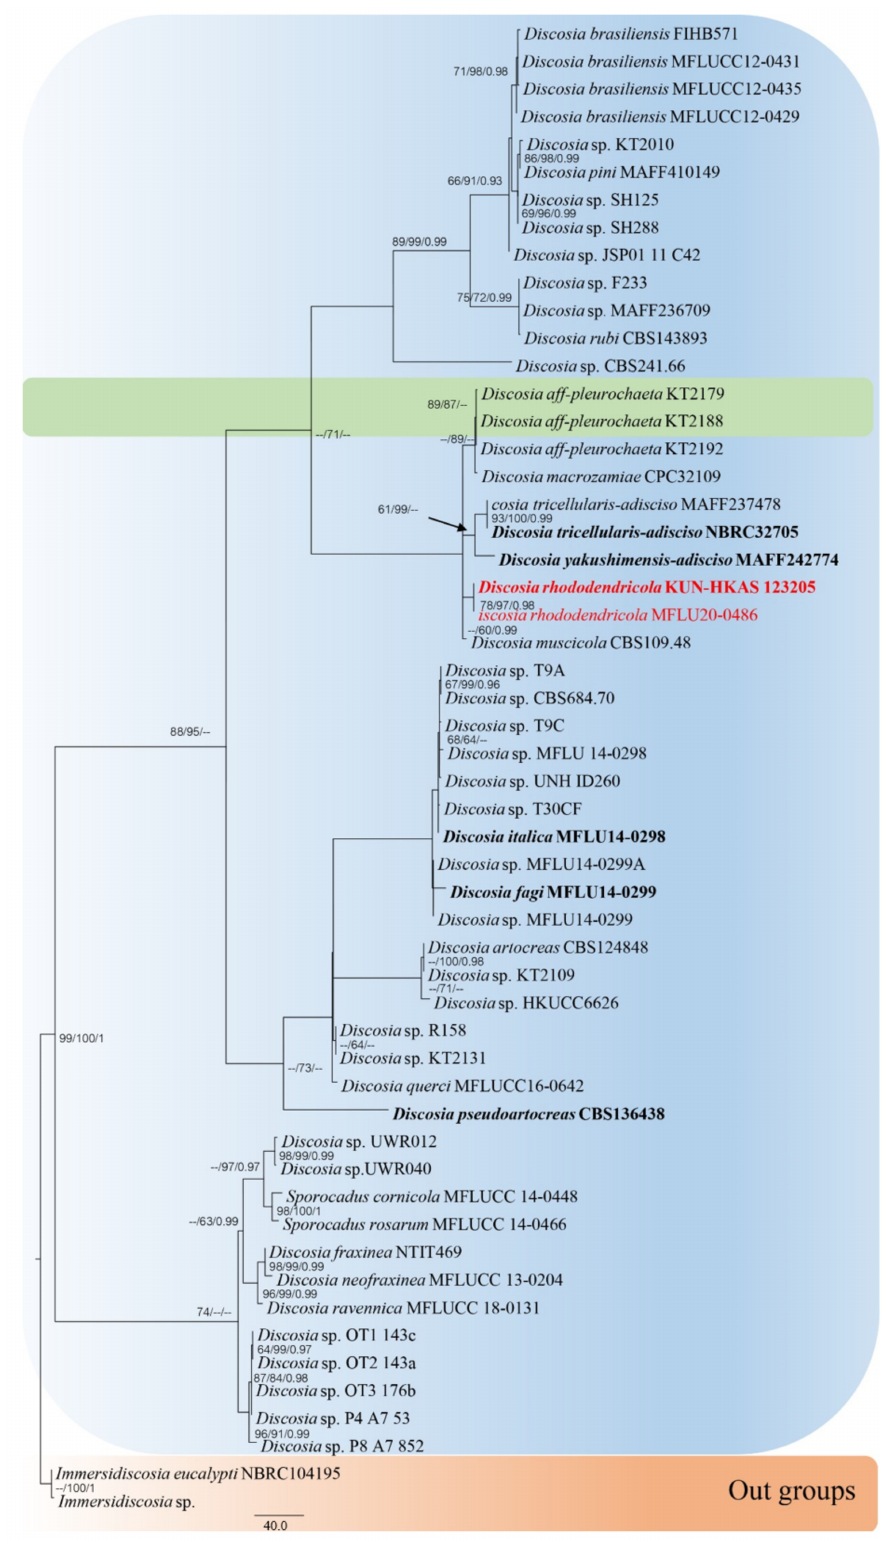
Figure 1. Phylogram generated from maximum parsimony analysis of LSU, ITS, RPB2, TEF1 and TUB2 gene regions. Bootstrap support values for MP and ML equal to or greater than 60% and Bayesian posterior probabilities (PP) equal to or greater than 0.90 are defined as MP/ML/PP above or below the nodes. Taxonomic novelty is indicated in red. The tree is rooted with Immersidiscosia eucalypti (MFLU 16-1372) and (NBRC